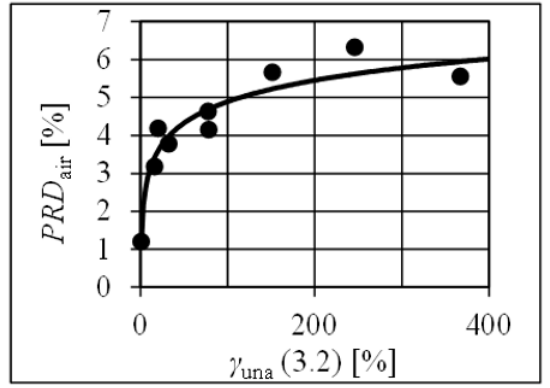
Figure 6. ProportionalmeanrutdepthofAC16asphaltmixesversus unrecovered strain of different binders